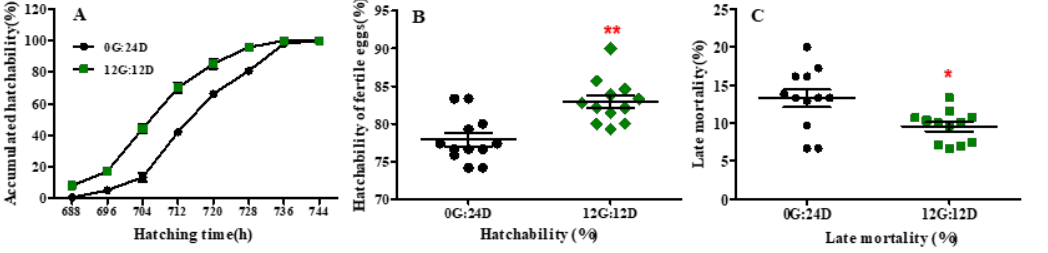
Figure 1. Hatch accumulation and hatch performance of goose eggs under green light and dark. ( A ) Hatch accumulation of eggs. ( B ) Hatchability of fertile eggs. ( C ) Late mortality of goose embryos. Data are presented as mean ± SEM (n = 12 replicates per group at each incubation time). * in red color indicated p < 0.05, ** in red color indicated p < 0.01. Abbreviations: 0G: 24D, dark group; 12G:12D, green light